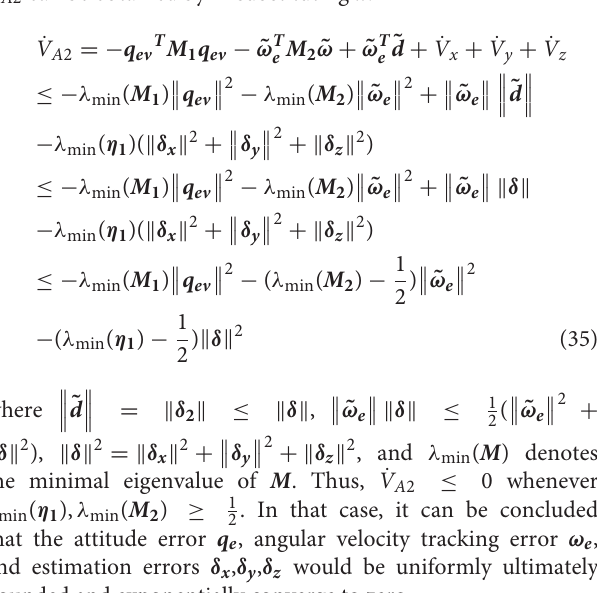
FIGURE 4 | Prototype of human joint.